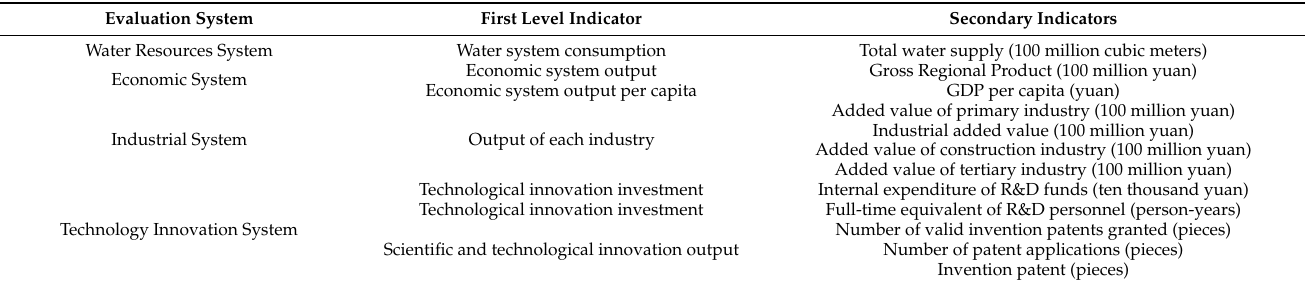
Table 1. Evaluation